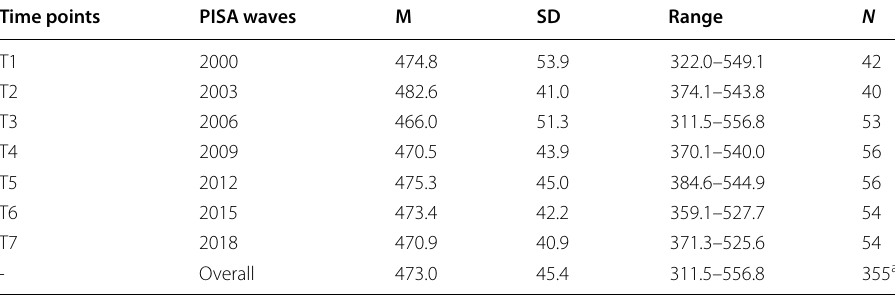
Table 1 Pooled Means and Standard Deviations of PISA Reading Literacy Scores Aggregated at the Country